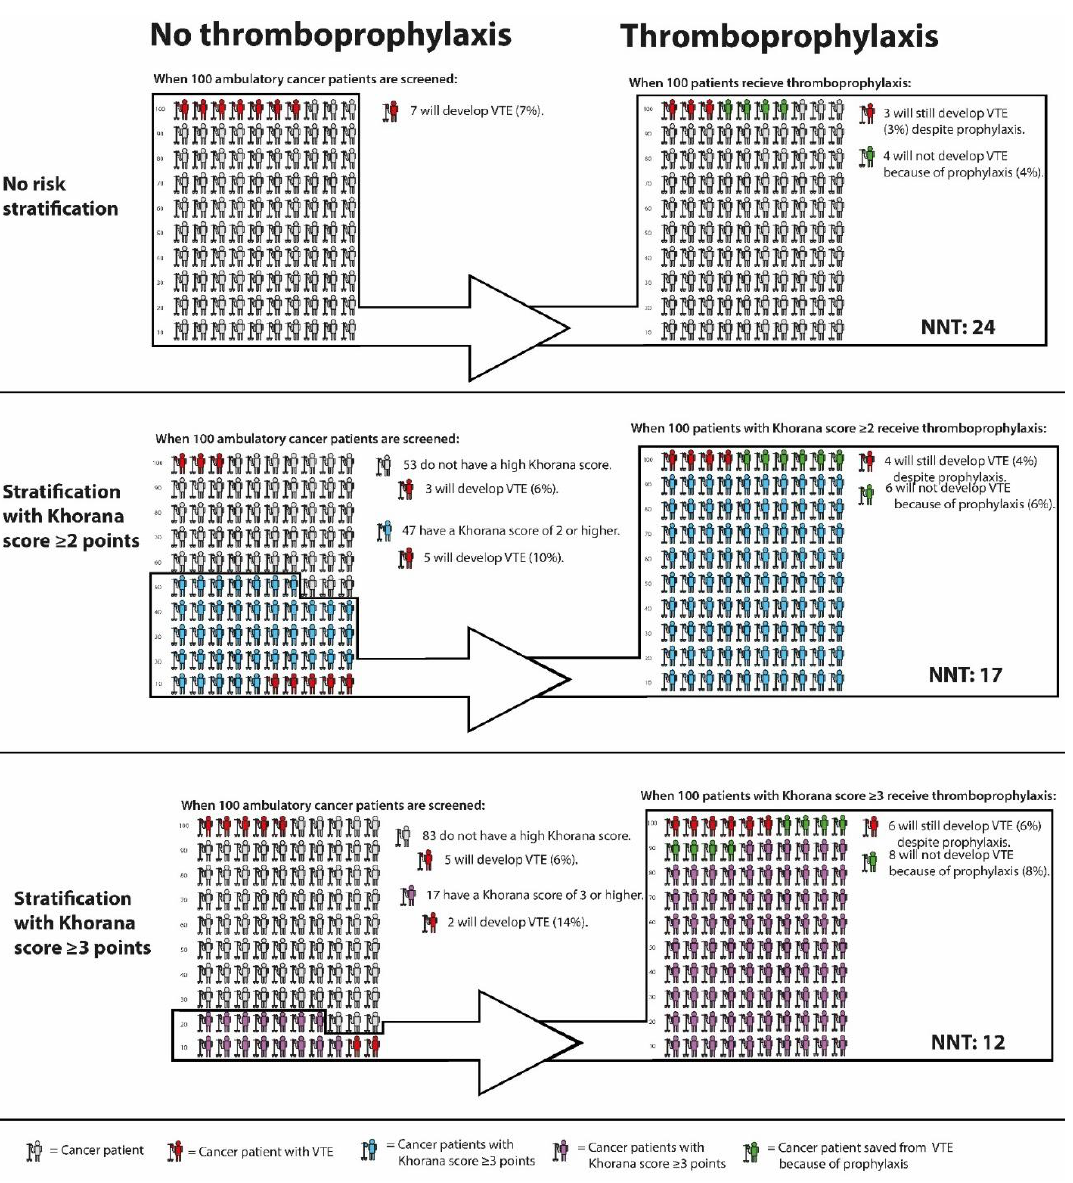
Figure 1. VTE incidence in cancer patients with and without thromboprophylaxis, stratified